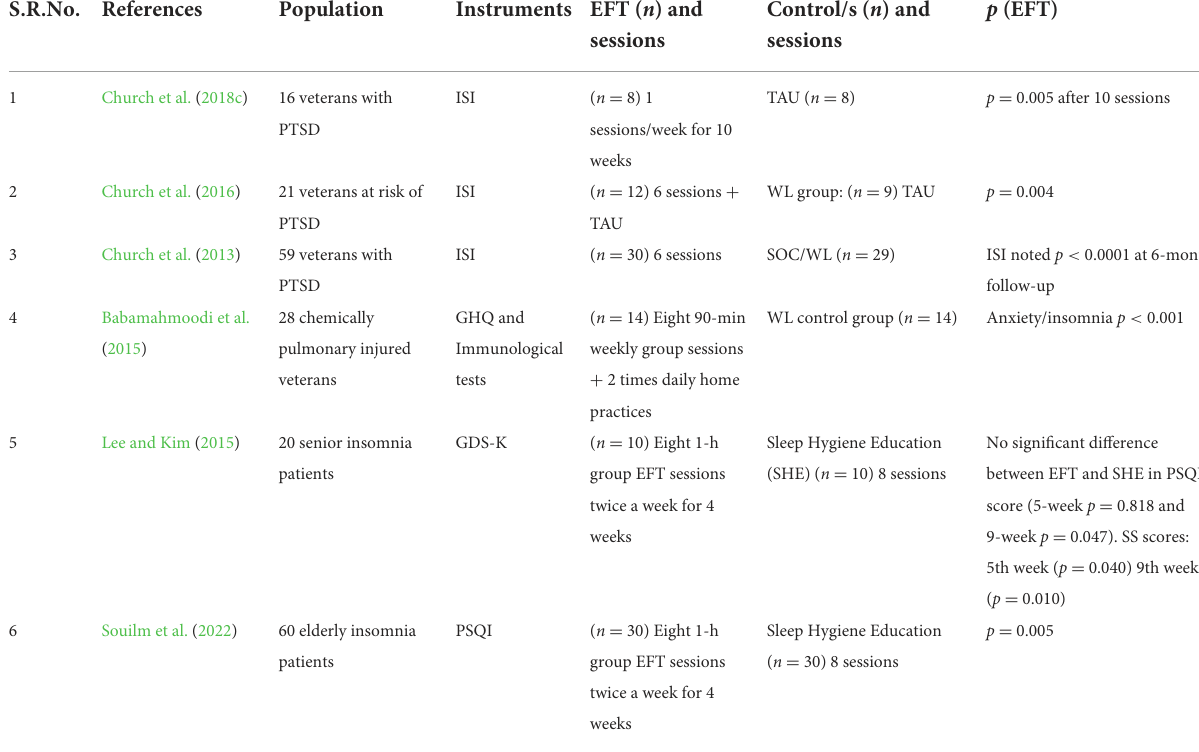
TABLE 13 RCTs measuring insomnia as a primary or secondary